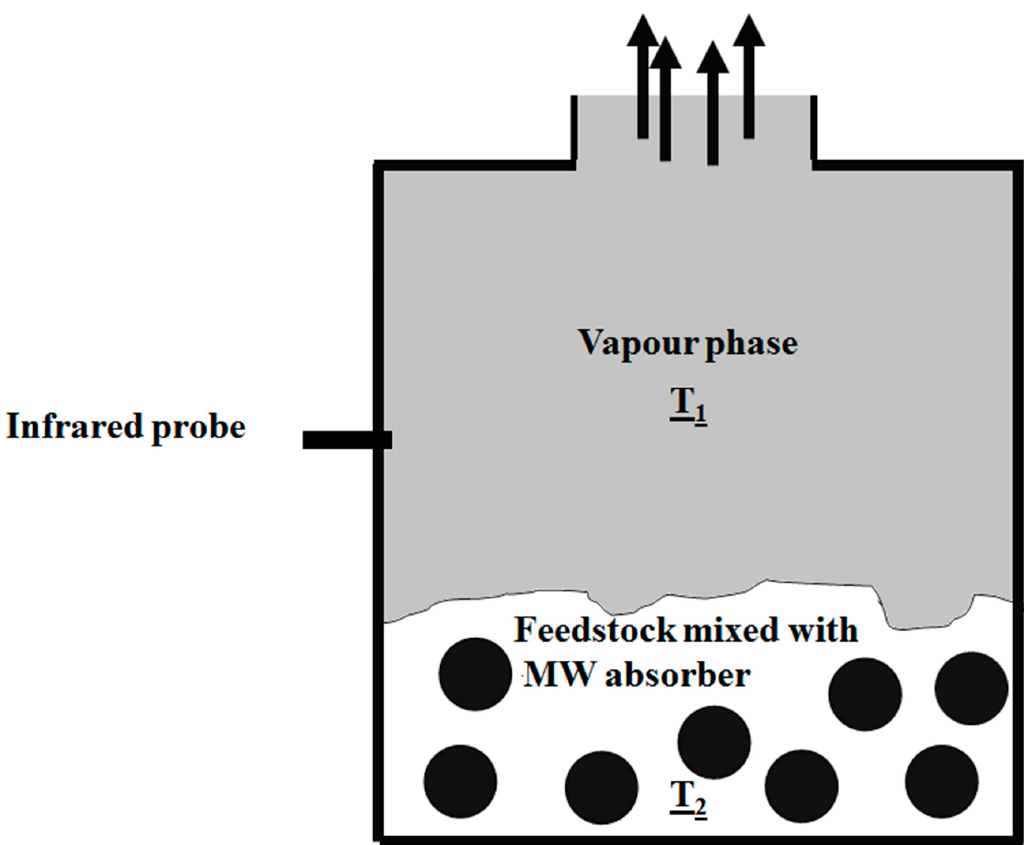
Figure 3. Main problems related to temperature measurements caused by vapour formation during pyrolytic